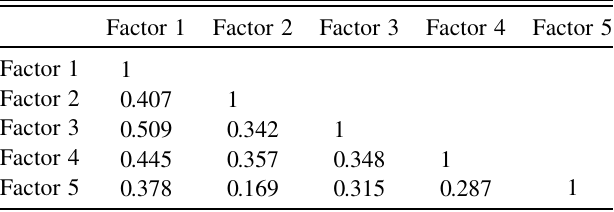
TABLE IV. Correlation coefficients between factors in the nonorthogonal five-factor